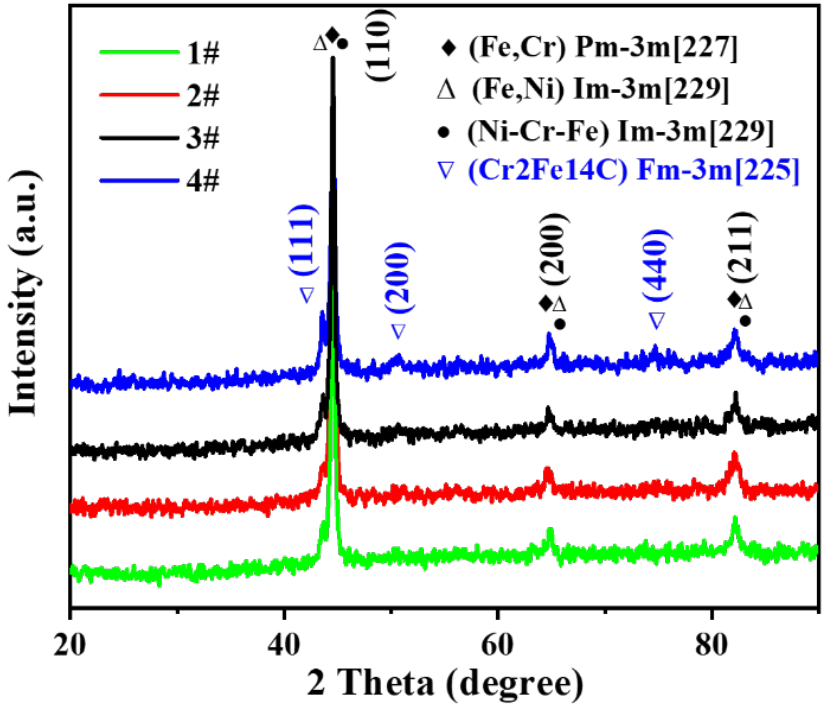
Figure 2. XRD patterns of coatings under different field-assisted types.